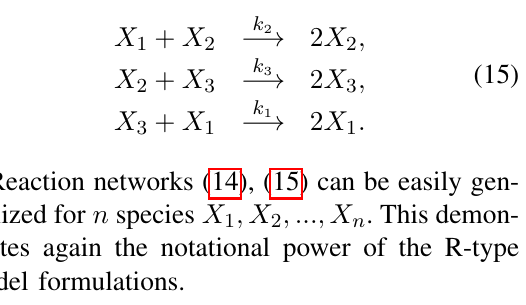
function (13) through the inflection point (0 , 1 / 2) intersects the abscissa at the point ( − δ, 0) , δ > 0